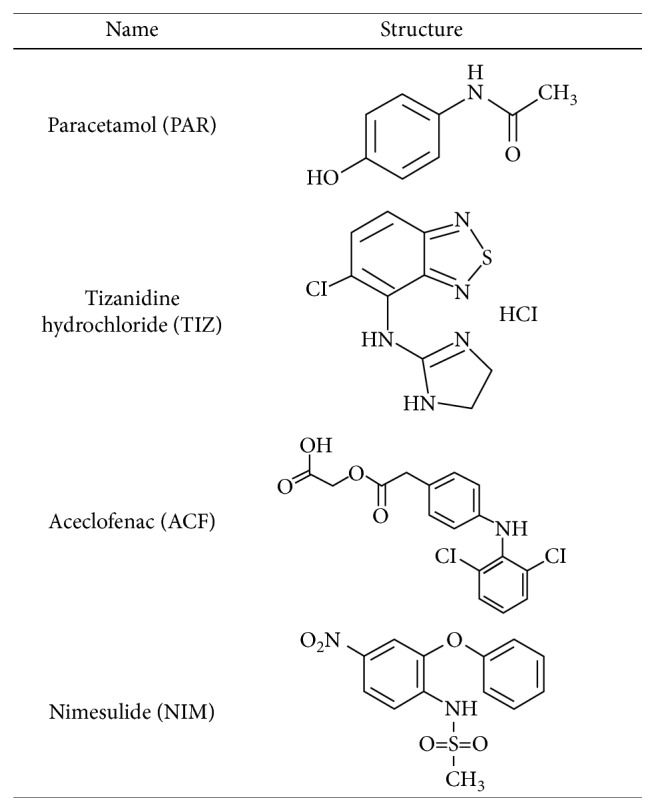
The chemical structures of paracetamol (PAR), tizanidine (TIZ), aceclofenac (ACF), and nimesulide (NIM).